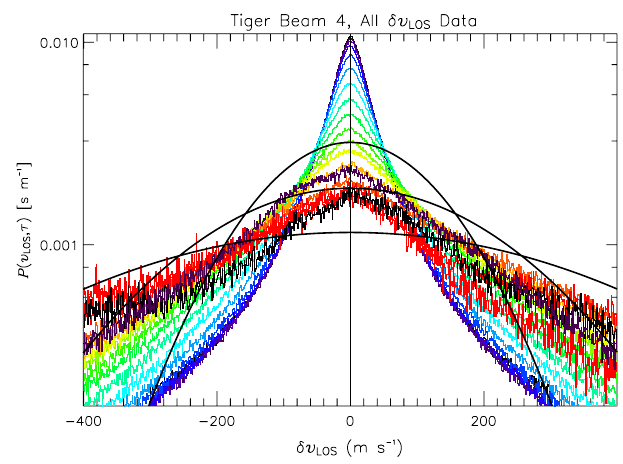
Fig. 4. Probability density functions (PDFs) of the velocity fluc- tuations δ v los observed on Tasmania beam 4 during the campaign intervals listed in Table 1. The fluctuating coloured curves corre- spond to temporal scales τ =1s (black), 2 (purple), 4 (blue), ..., 86400s (1 day) (back to purple). The smooth black curves rep- resent Gaussian functions with the same standard deviation as the measured PDFs at τ =1, 64 and 86400s. The number of δ v los sam- ples ranged from a maximum of 2915381 at τ =1s to a minimum of 189483 at τ =65536s. A bin size of 1ms − 1 was used throughout this